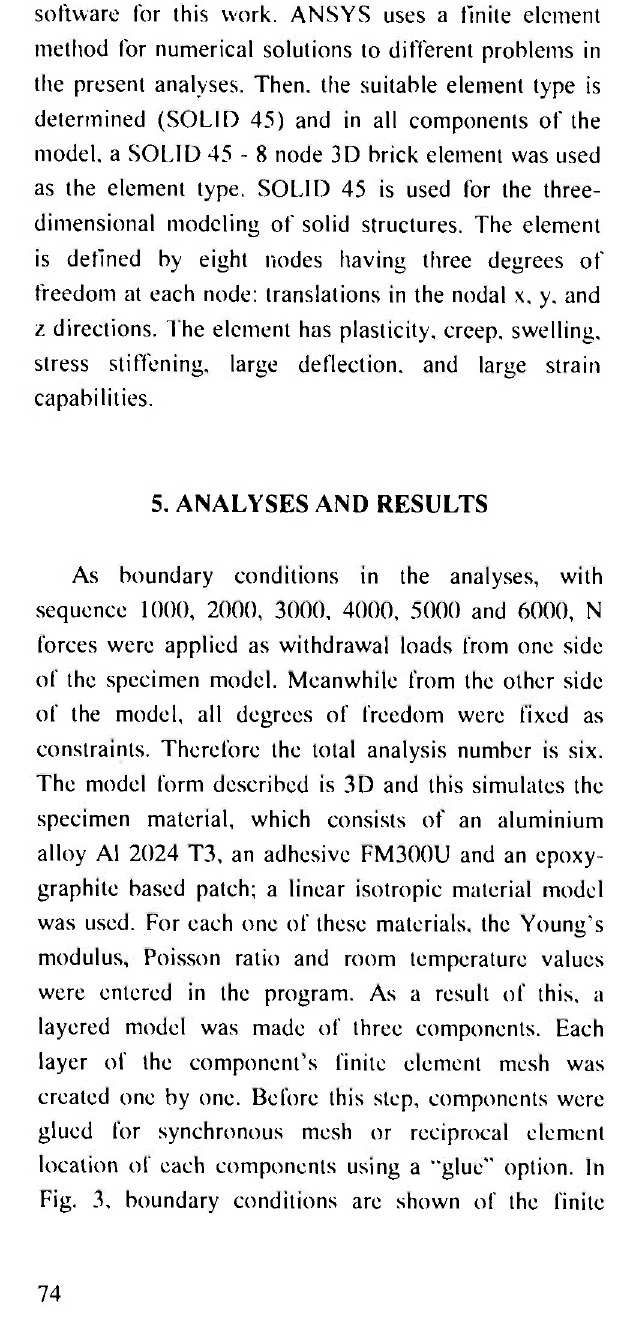
Fig. 3: Boundary conditions and the meshed patched structure.